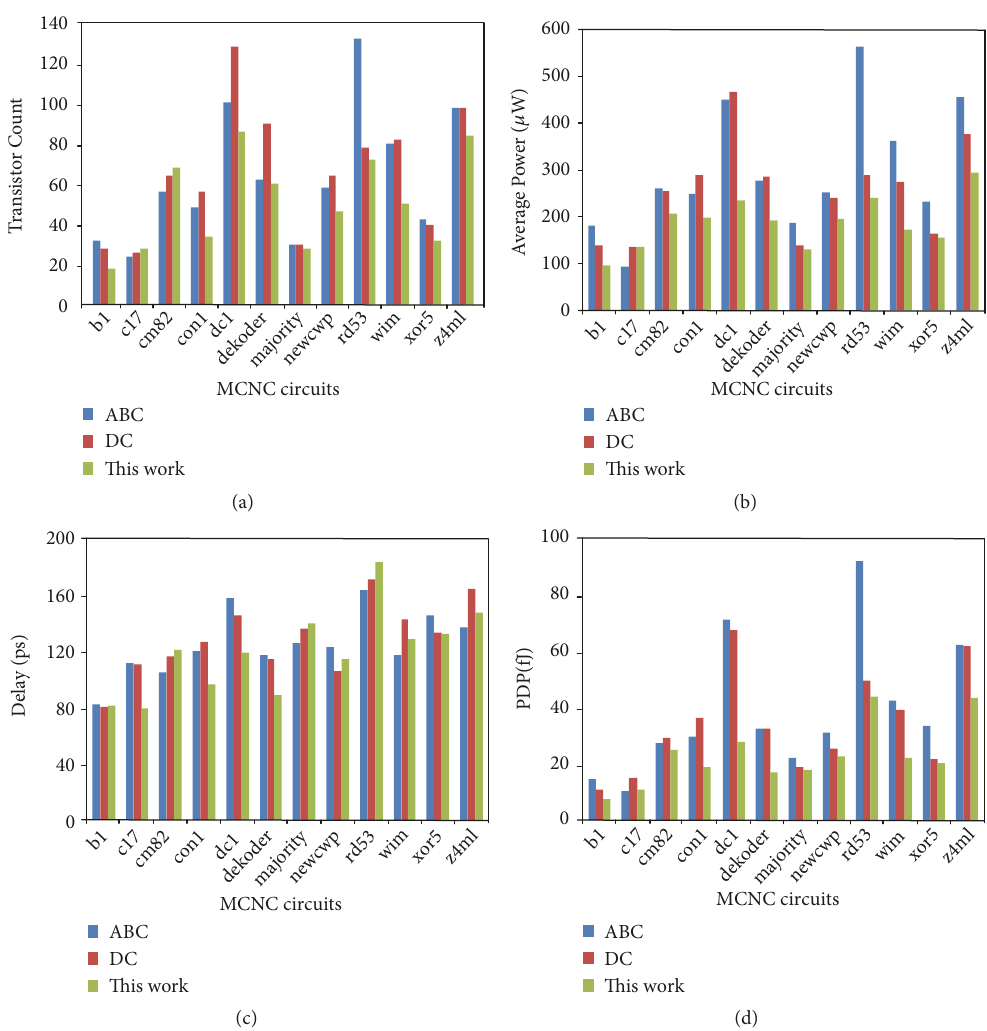
Figure 6: Comparison between the simulation results of ABC, DC, and this